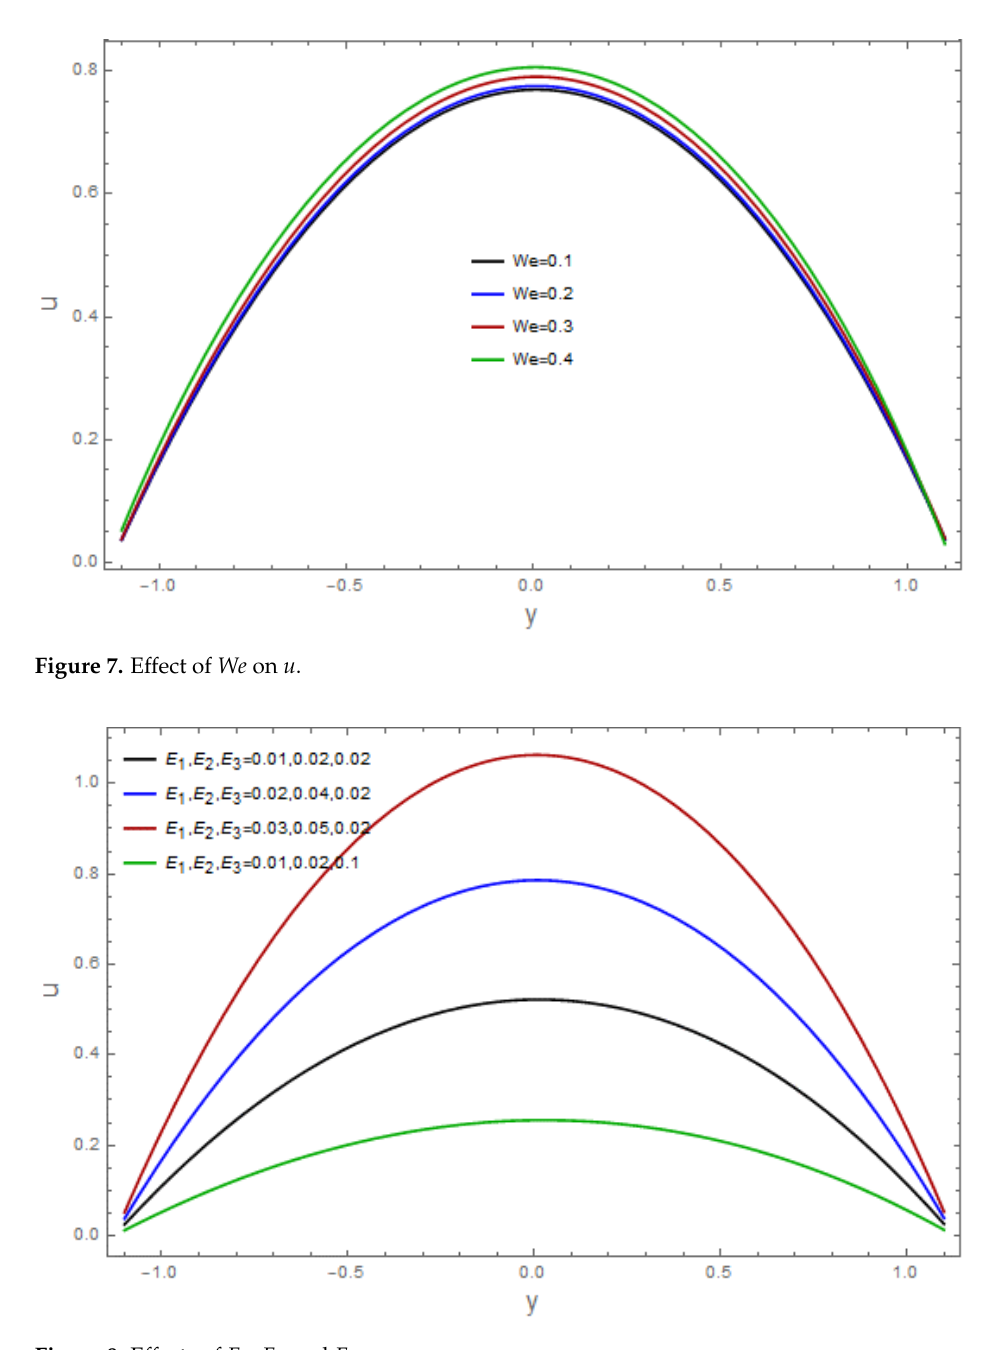
1 , E 2 and E 3 on u